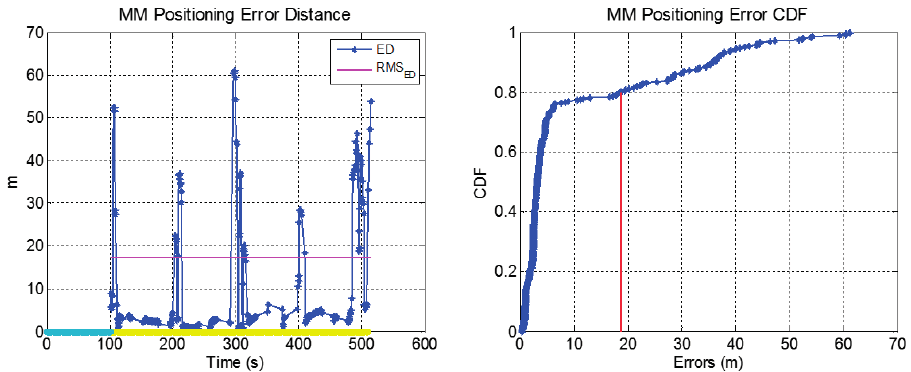
Figure 19. MM position errors at